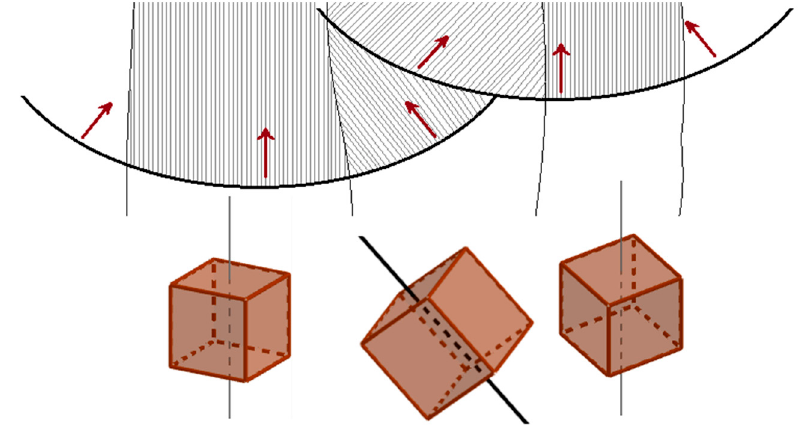
Figure 23. Schematic model of the solidification of columnar grains with different crystallographic orientation. The dendrites of the middle grain change their growth direction of 90° at the melt pool boundary following the local thermal gradients (red arrow) resulting in a zig-zag shape similar to that observed in Figure 9b.